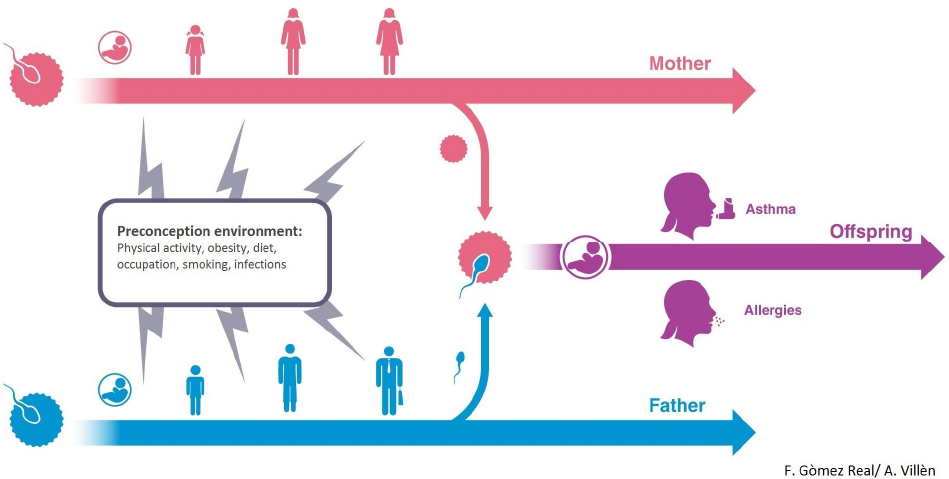
Figure 1. Maternal and paternal lifeline and possible influence on offspring asthma and allergies.